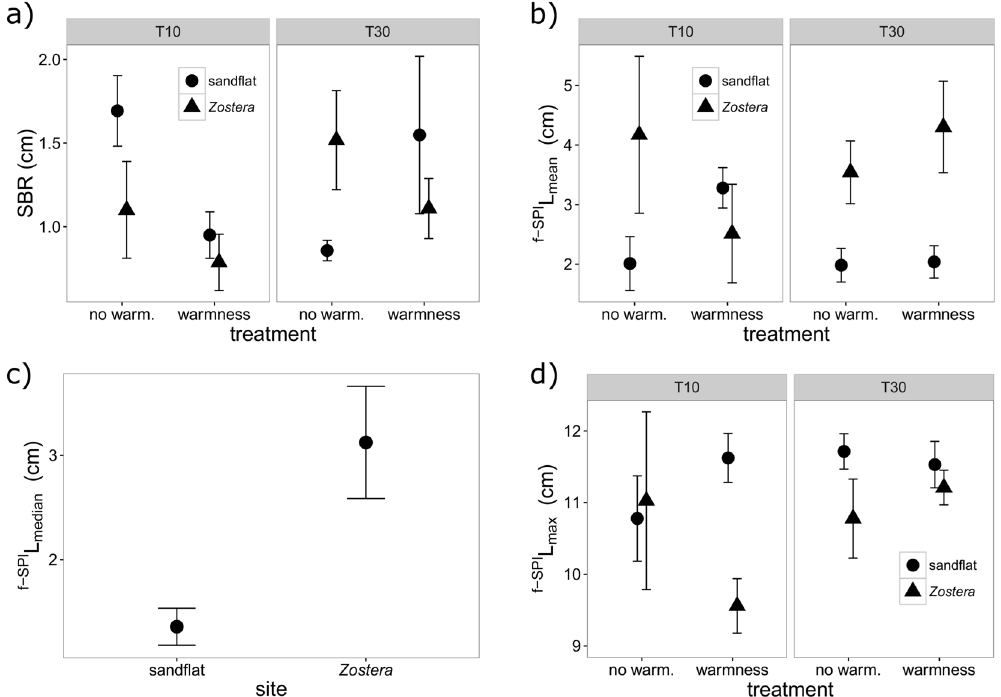
Figure 5. The significant effects of warmness treatment, site and time on surface boundary roughness (SBR) ( a ), f-SPI L mean ( b ), f-SPI L median ( c ) and f-SPI L mean ( d ) (cm, mean ± s.e.). For clarity, jitter has been applied to the x = argument of the plot function to avoid